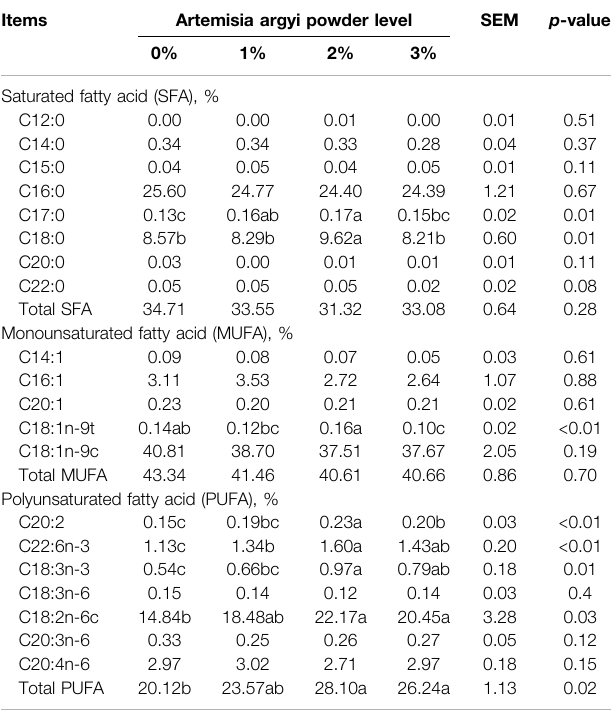
TABLE3| EffectsofArtemisiaargyiMealonFattyAcidCompositioninEggYolkof Roman Laying Hens (%). Items